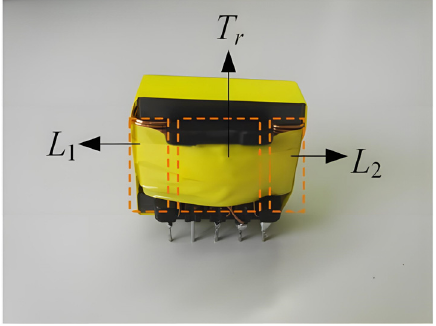
Figure 15. Photo of the magnetic integrated inductance and transformer.